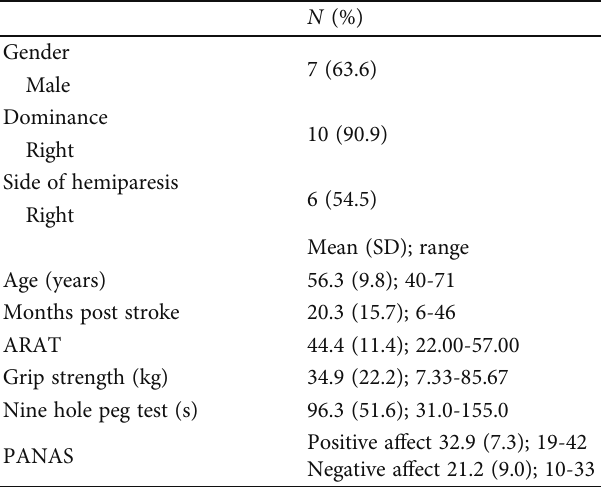
Table 1: Baseline characteristics of participants who completed the study ( n = 11